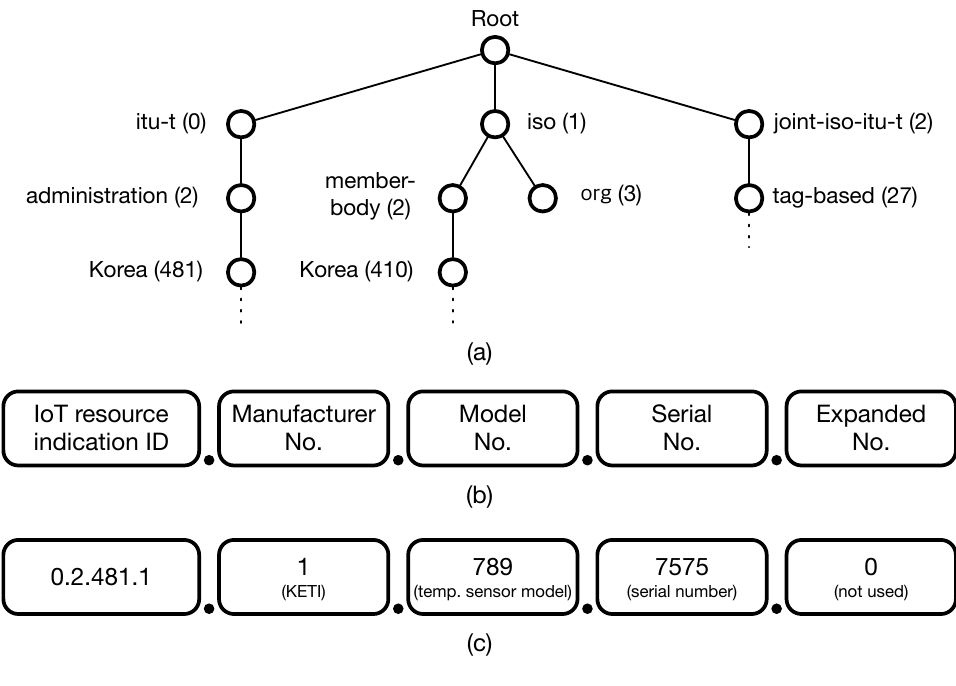
Figure 8. The OID-based IoT resource identification structure: ( a ) the OID hierarchy, ( b ) the proposed ID structure for IoT devices, ( c ) an OID example of the temperature sensor whose manufacturer is KETI , model number 789 , and serial number 7575 , provided the root for IoT resource indication in Korea is 0.2.481.1